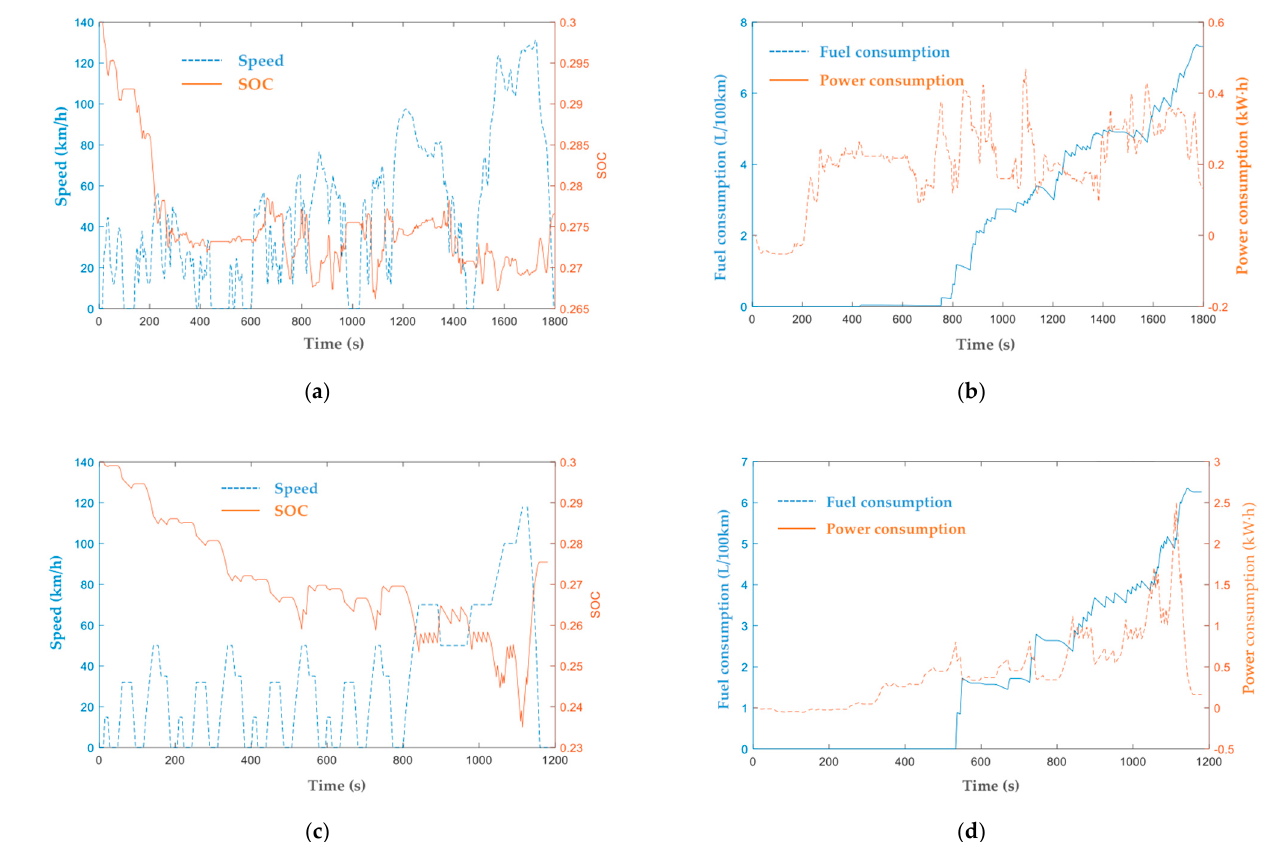
Figure 9. The curve of the SOC, speed, fuel consumption, and power consumption by using the ECMS algorithm under the WLTC and the NEDC cycles: ( a ) The curve of the SOC under the WLTC cycle; ( b ) The curve of the fuel consumption and power consumption under the WLTC cycle; ( c ) The curve of the SOC under the NEDC cycle; ( d ) The curve of the fuel consumption and power consumption under the NEDC cycle.